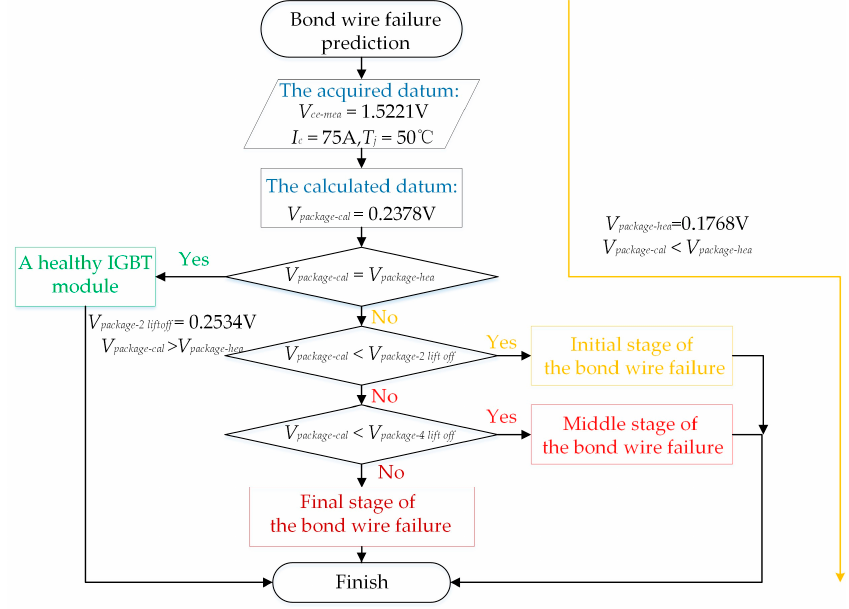
Figure 11. The diagnosis process for IGBT module bond wire failure.